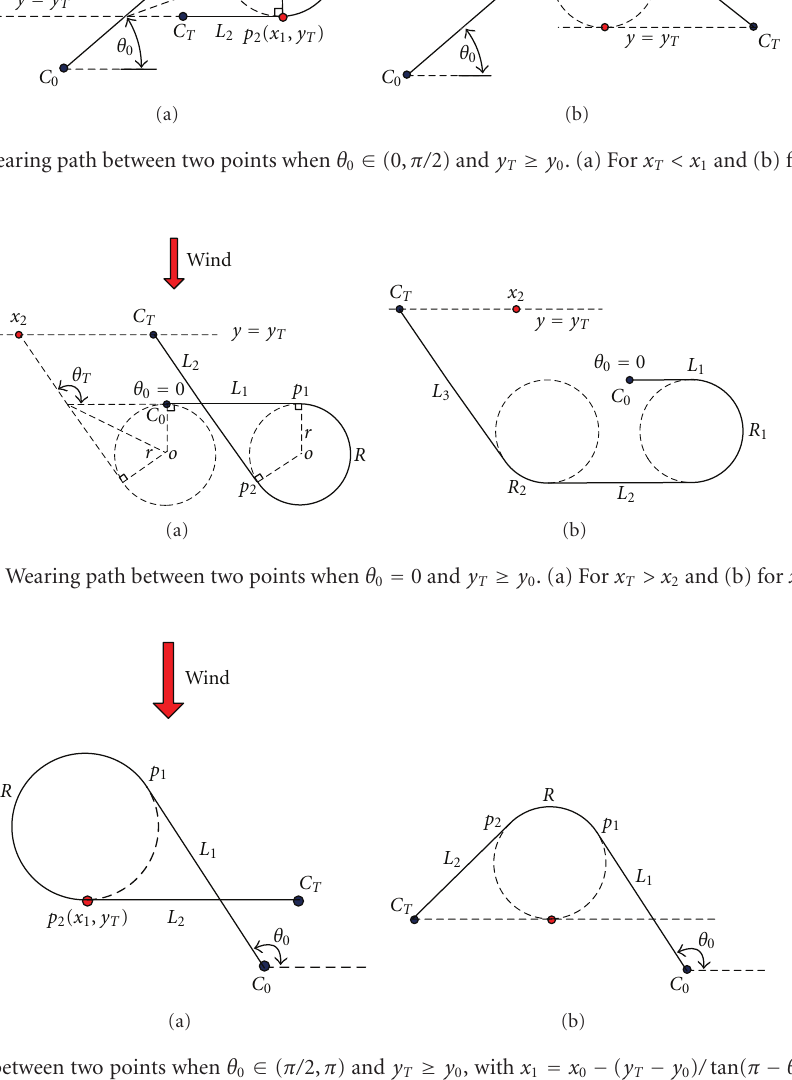
Figure 12: Wearing path between two points when θ 0 ∈ ( π/ 2, π ) and y T ≥ y 0 , with x 1 = x 0 − ( y T − y 0 ) / tan( π − θ 0 ) − r/ tan(( π − θ 0 ) / 2). (a) For x T > x 1 and (b) for x T ≤ x 1 .